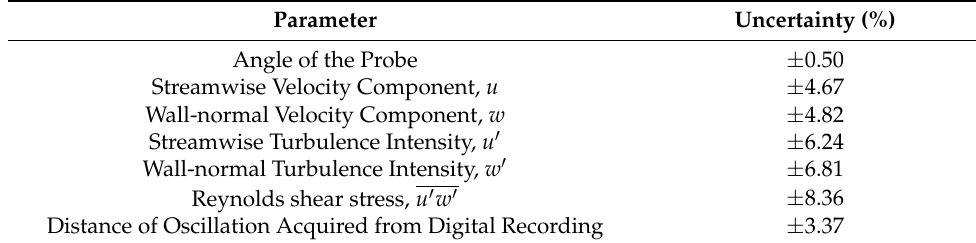
Table 1. Summary of uncertainty estimation for results parameters.